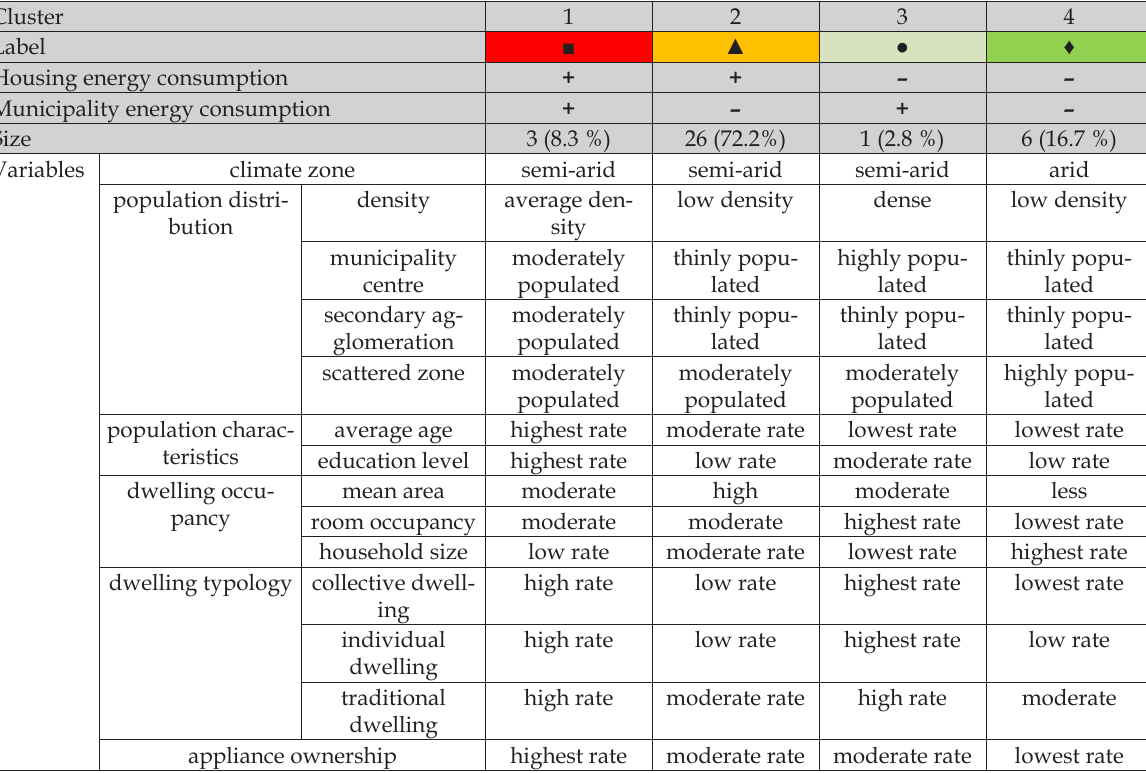
Table 4. Characteristics of clusters.